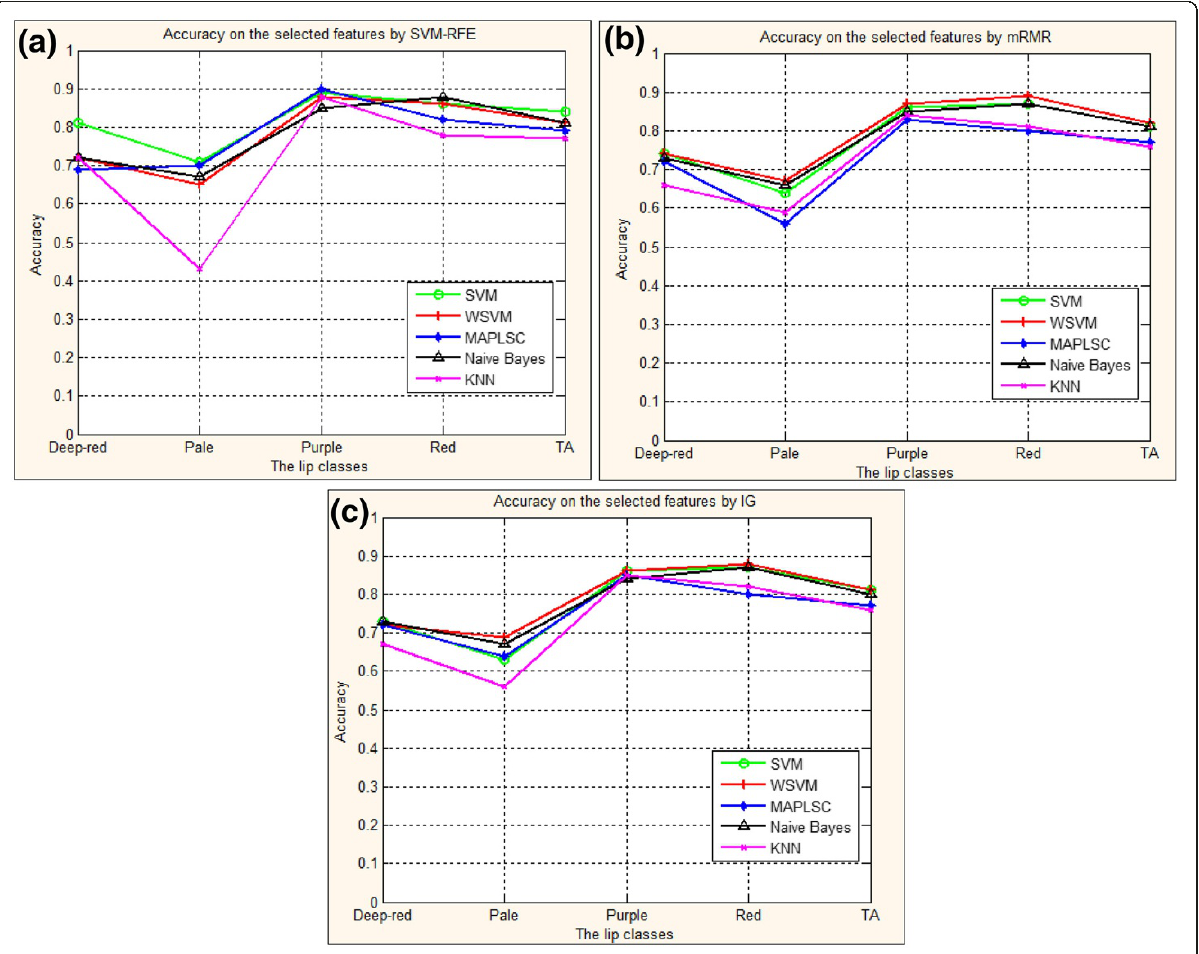
Figure 8 (a). Prediction accuracy of lip image classification using SVM, WSVM, MAPLSC, Naïve Bayes and kNN on the 9 selected features by SVM-RFE. ( b ): Prediction accuracy of lip image classification using SVM, WSVM, MAPLSC, Naïve Bayes and kNN on the selected features by mRMR. ( c ): Prediction accuracy of lip image classification using SVM, WSVM, MAPLSC, Naïve Bayes and kNN on the selected features by IG